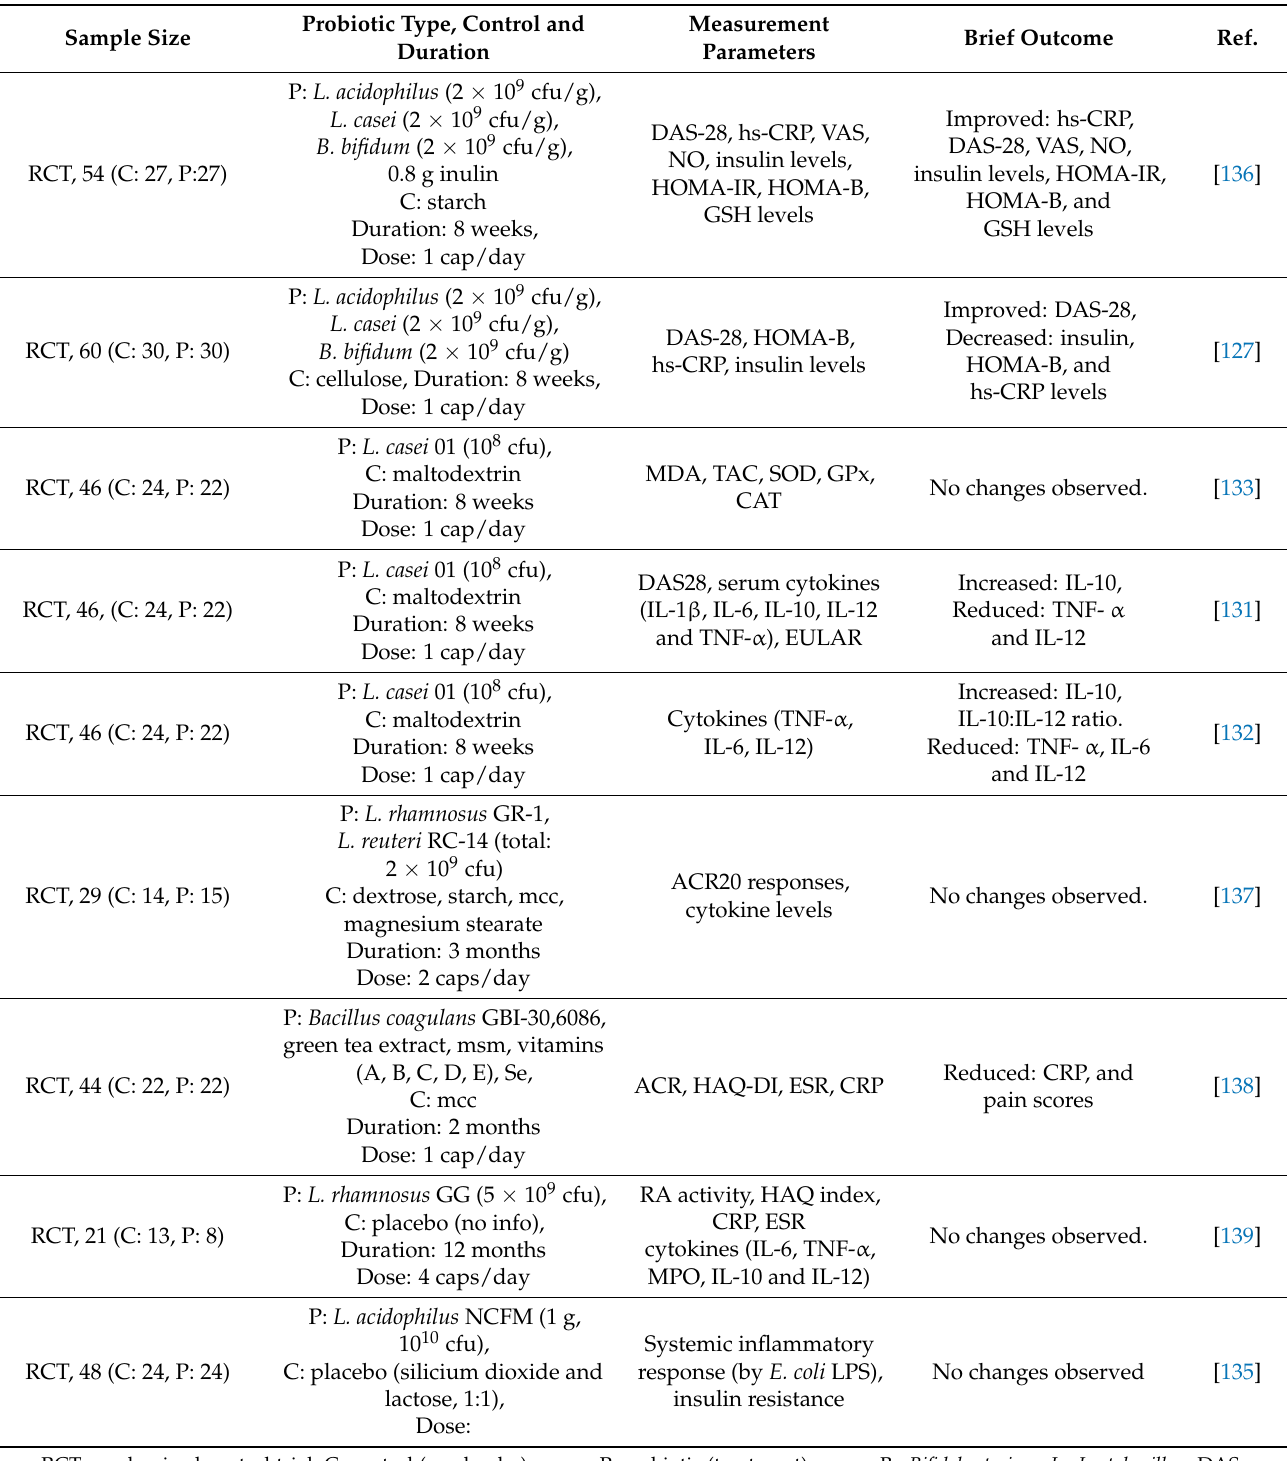
Table 2. Effects of probiotics in clinical